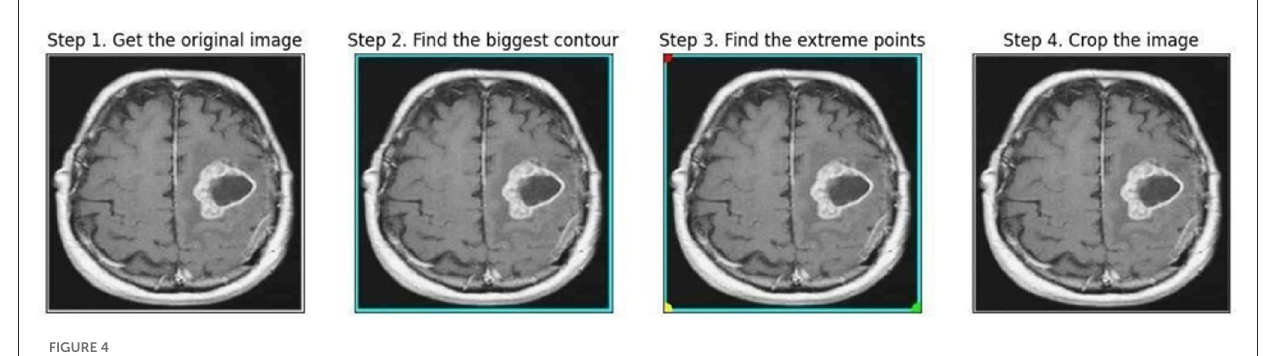
FIGURE4 Steps involved in